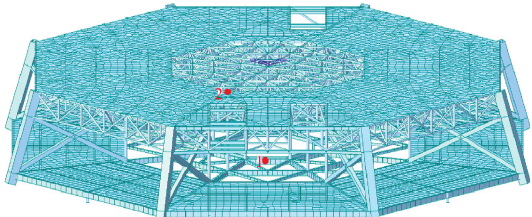
Figure 2: Global simplified FE model of the